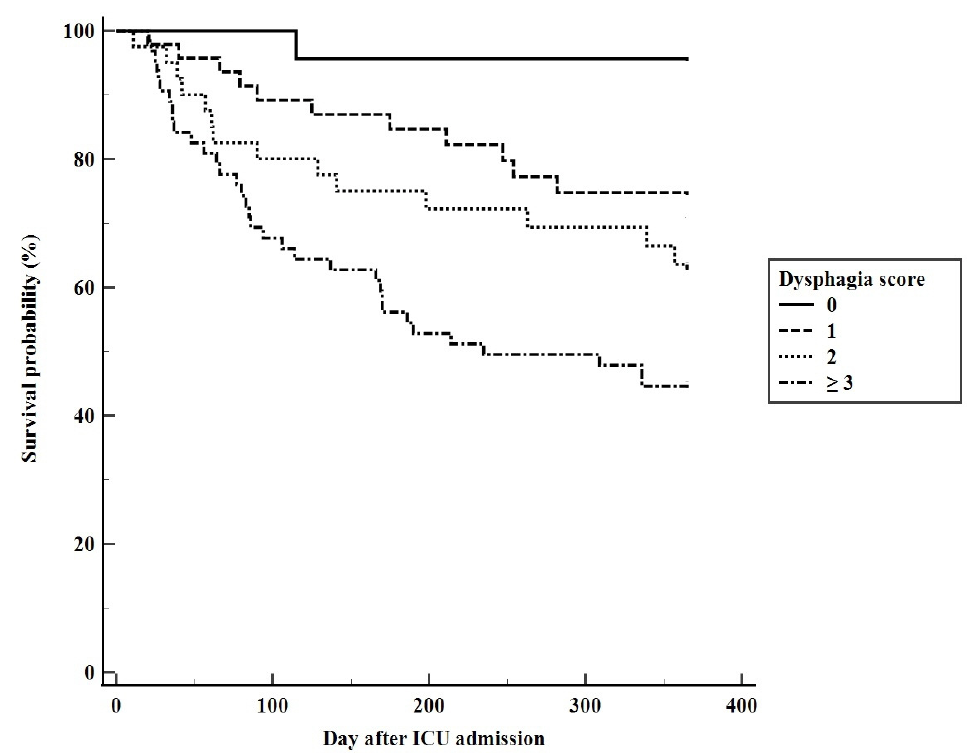
Figure 4. Kaplan–Meier analyses of patient survival curves 1 year after ICU admission as a function of dysphagia score.